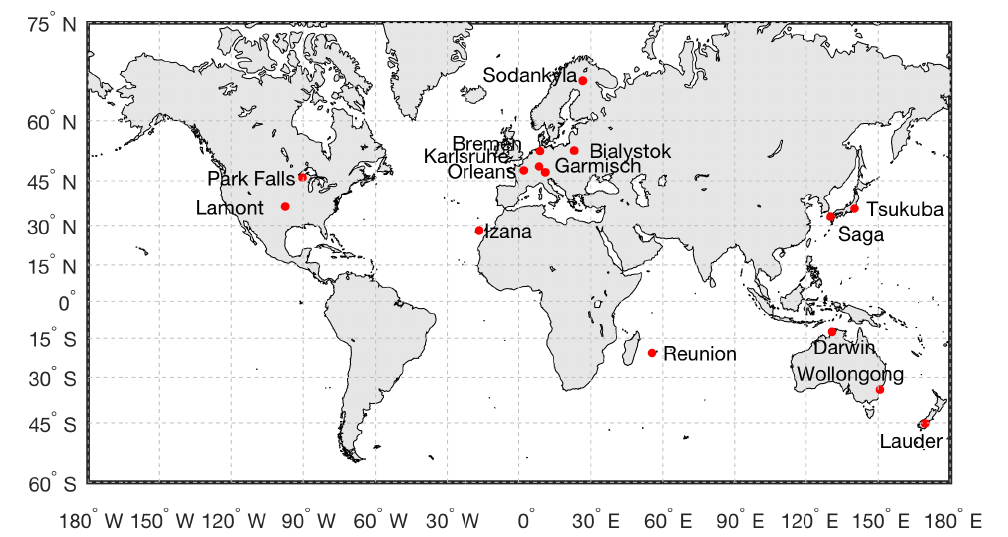
Figure 2. TCCON sites used to evaluate GOSAT XCH 4